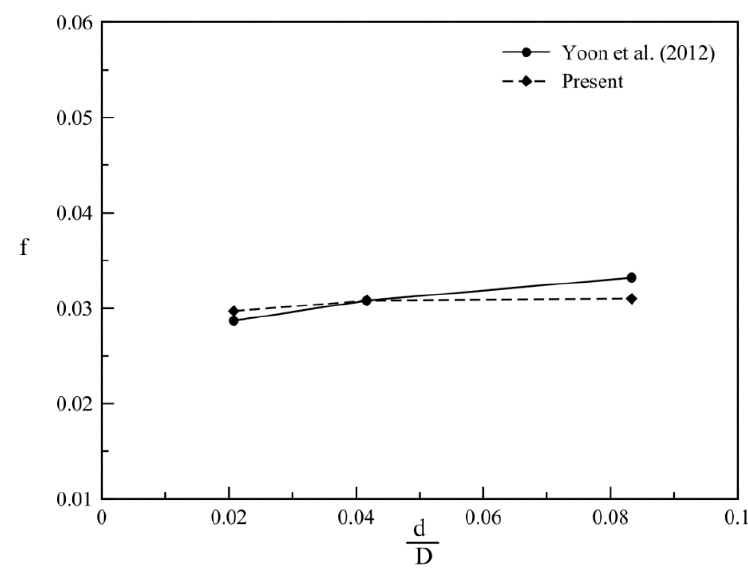
Figure 4. Friction factor for different d/D values at Re = 25,000. Using the Reynolds analogy for helically coiled tubes, the local Nusselt number around the circumference of the helical tube wall was determined. For the different curvature ratios (d/D) with Re = 25,000, the local Nusselt numbers were normalized with the average Nusselt number obtained using Equation (18). The local Nusselt number distribution to the average Nusselt number around the tube wall’s circumference is shown in Figure 5. From the inner side of the coil, the angle was measured clockwise. The centrifugal force of the spiral tube increases the heat transfer by creating a secondary vortex in the tube and simultaneously increases the flow rate outside the spiral coil. The effect of reducing the